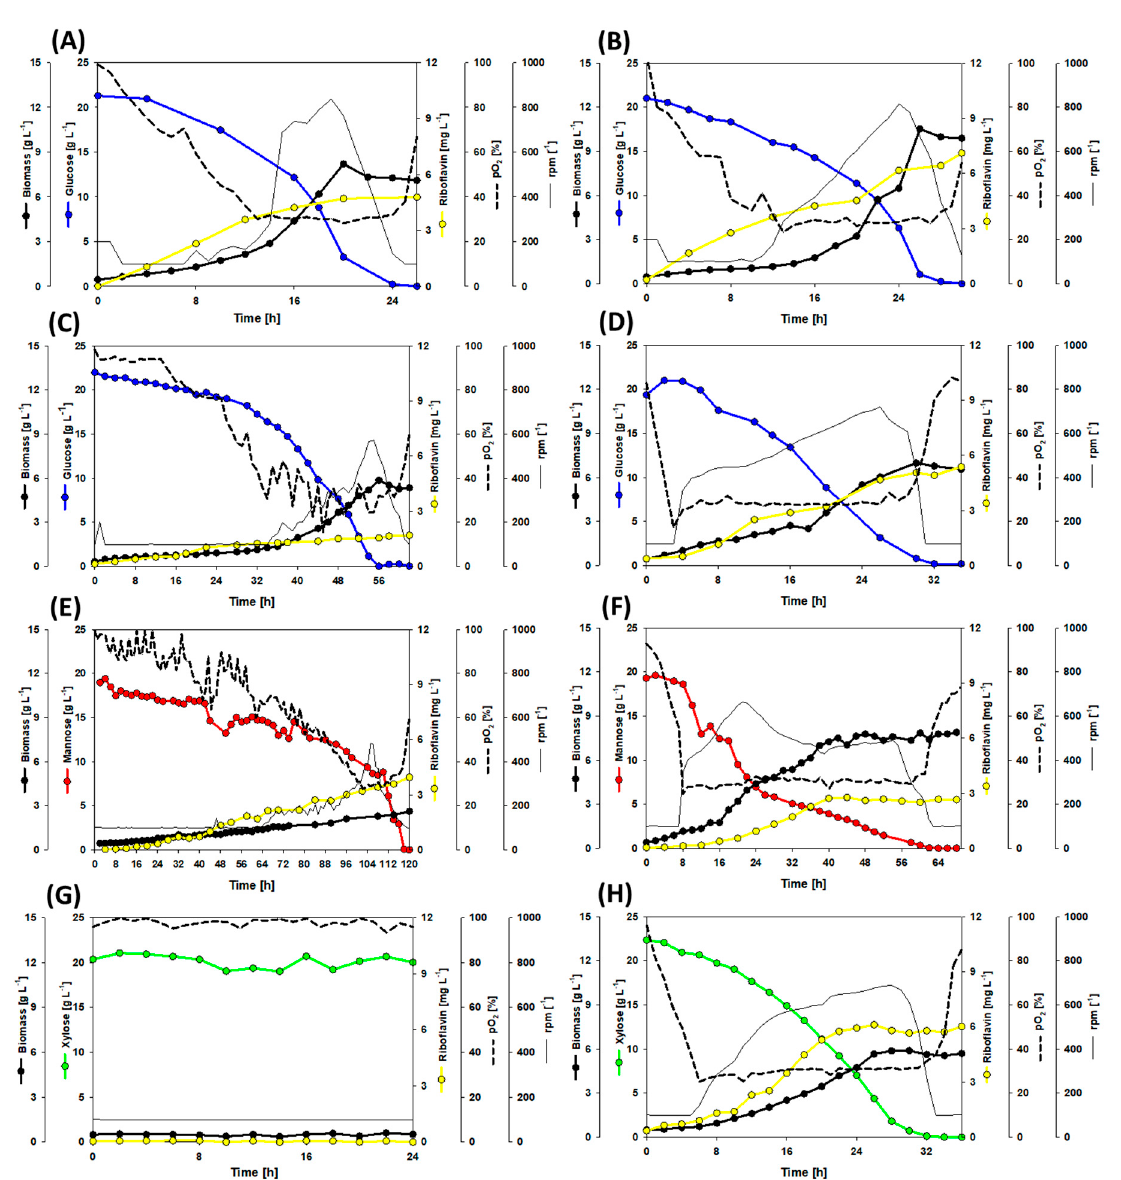
Figure 2. Growth and production of the strains RiboGlu, RiboMan, RiboXyl, and RiboSSL during bioreactor batch fermentations with 20 g L − 1 glucose, mannose, or xylose as sole carbon source. The combination of strain and sugar is as follows: ( A ) RiboGlu plus glucose; ( B ) RiboMan plus glucose; ( C ) RiboXyl plus glucose; ( D ) RiboSSL plus glucose; ( E ) RiboGlu plus mannose; ( F ) RiboMan plus mannose; ( G ) RiboGlu plus xylose; ( H ) RiboXyl plus xylose. Data is depicted as follows: glucose consumption (blue line), mannose consumption (red line), xylose consumption (green line), riboflavin accumulation (yellow line), biomass formation (thick black line), stirring profile (thin black line), and pO 2 profile (dotted line). One replication of each cultivation was carried out.